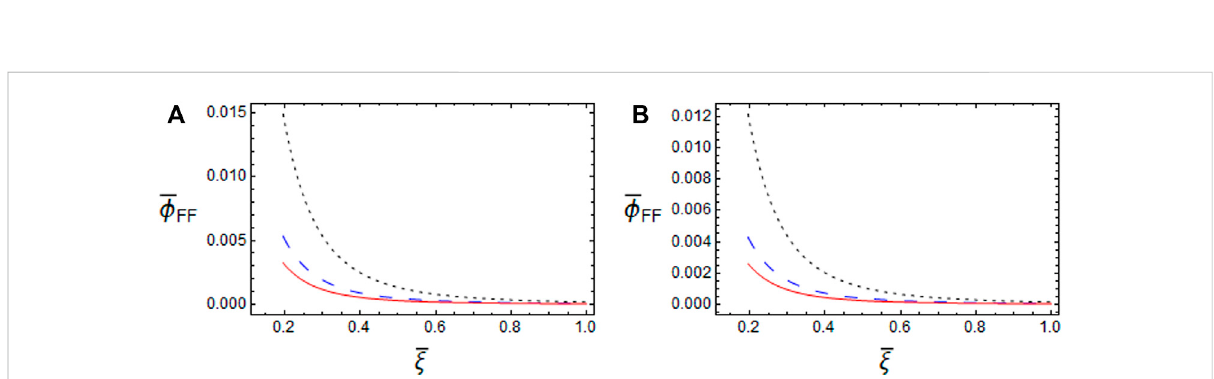
FIGURE 4 The pro fi les of the FF potential ( (cid:2) ϕ FF ) are plotted against the normalized axial distance ( (cid:2) ξ ) for varying the polarization coef fi cient ( R ) at low